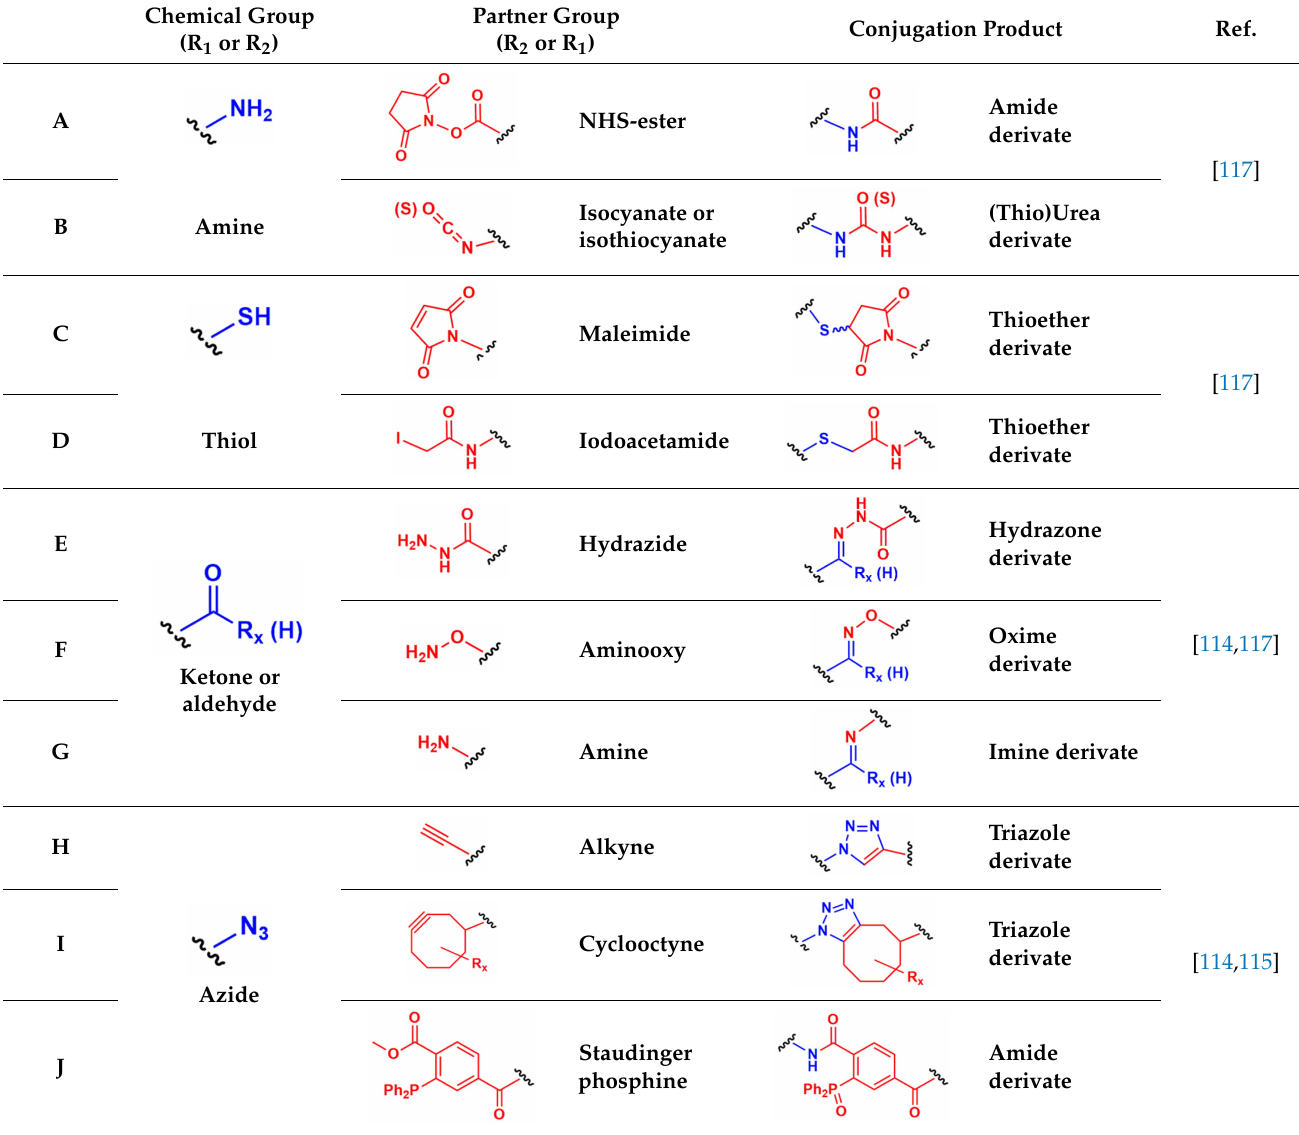
Table 1. Most common reactions for bioconjugation in living